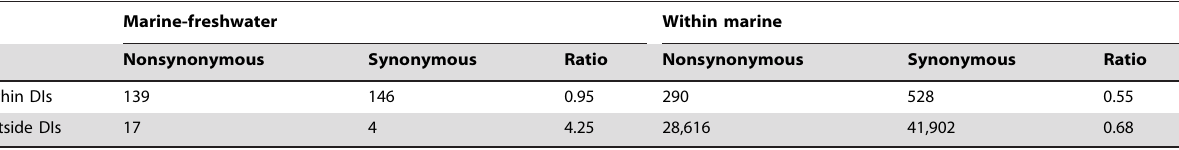
Table 3. SNPs in protein-coding